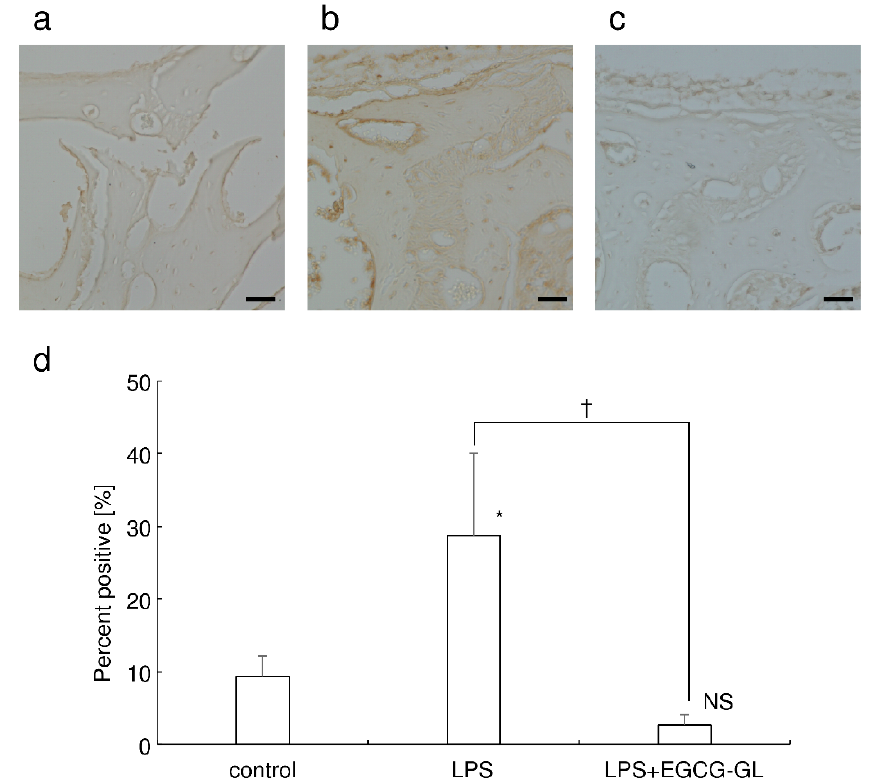
Figure 6. EGCG-GL attenuates LPS-mediated oxidative stress in mouse calvaria. Representative photographs of the control ( a ), LPS-treated ( b ), and LPS + EGCG-GL group ( c ) are shown. Scale bar: 100 µm. ( d ) Percent of positive staining in field. Mean values of five fields from different sections are shown. *: p <0.05 versus control. †: p < 0.05 between the samples. NS: not significant difference versus control.